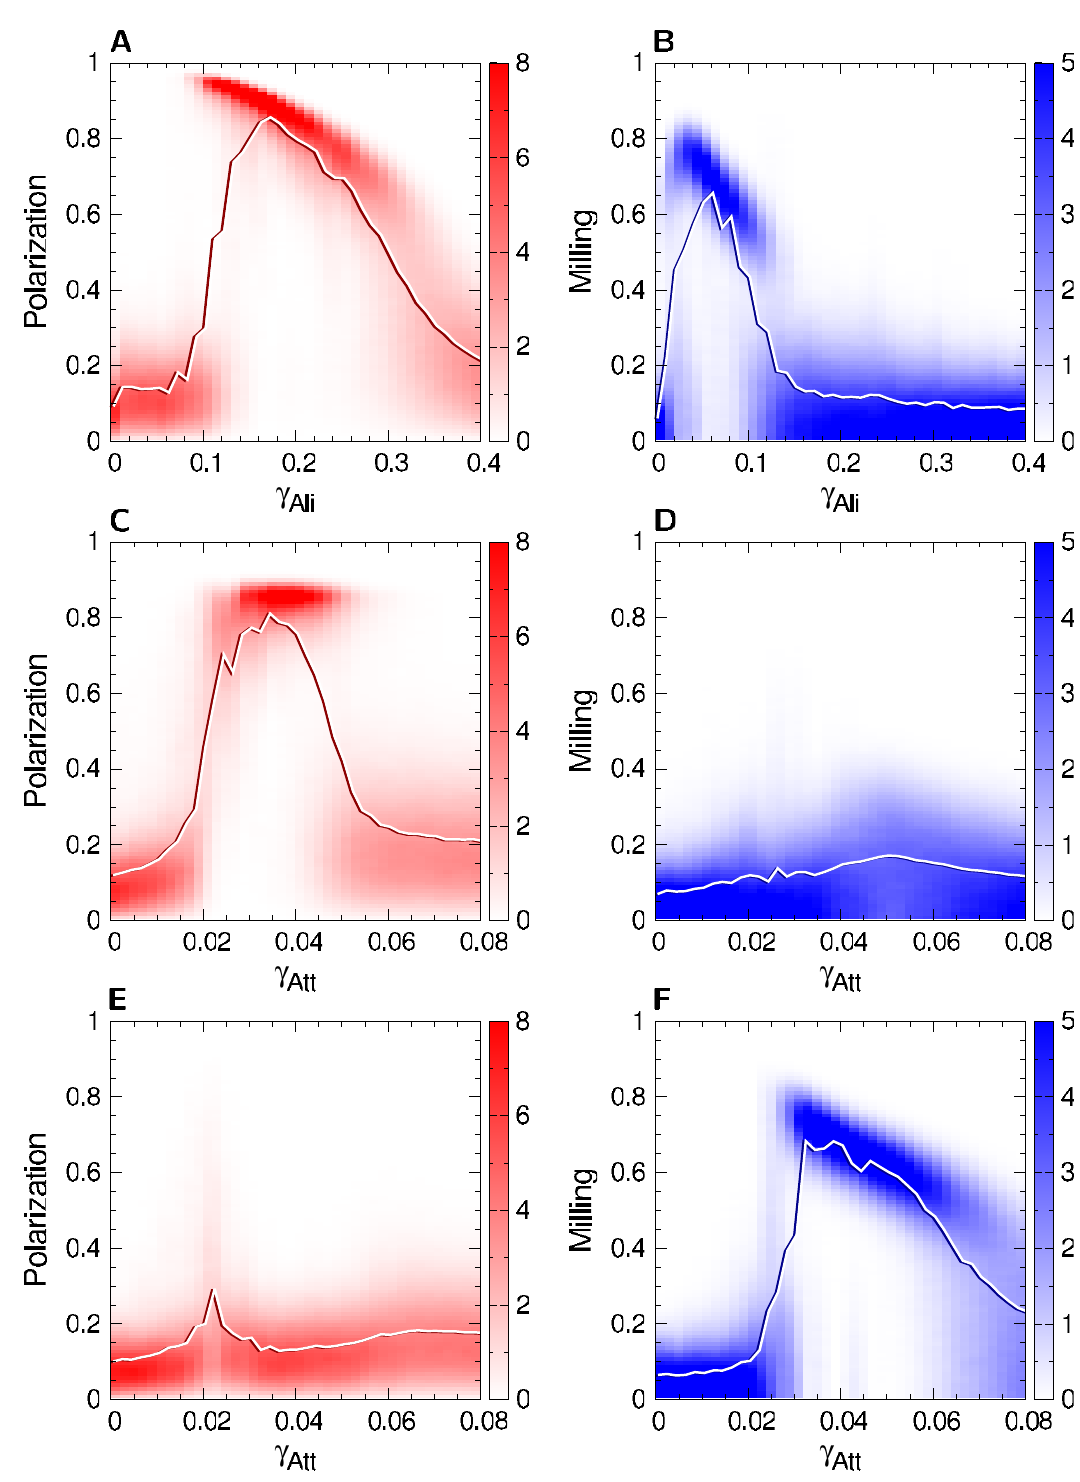
Fig 6. Polarization (red) and milling (blue) probability distribution functions and mean values (solid lines) along one vertical and two horizontal cuts of the phase diagram for the case k = 1. (AB) Vertical cut at γ Att = 0.0325, (CD) Horizontal cut at γ Ali = 0.2, and (EF) Horizontal cut at γ Ali = 0.05. Each vertical line is the probability distribution function (PDF) of the corresponding value of the parameter shown in the x -axis, for the parameter of each figure. Color intensity is proportional to the frequence of a value in the vertical axis. Solid lines are the corresponding mean value of each PDF. Interaction ranges are l Att = l Ali = 0.28 m and noise intensity is γ R =